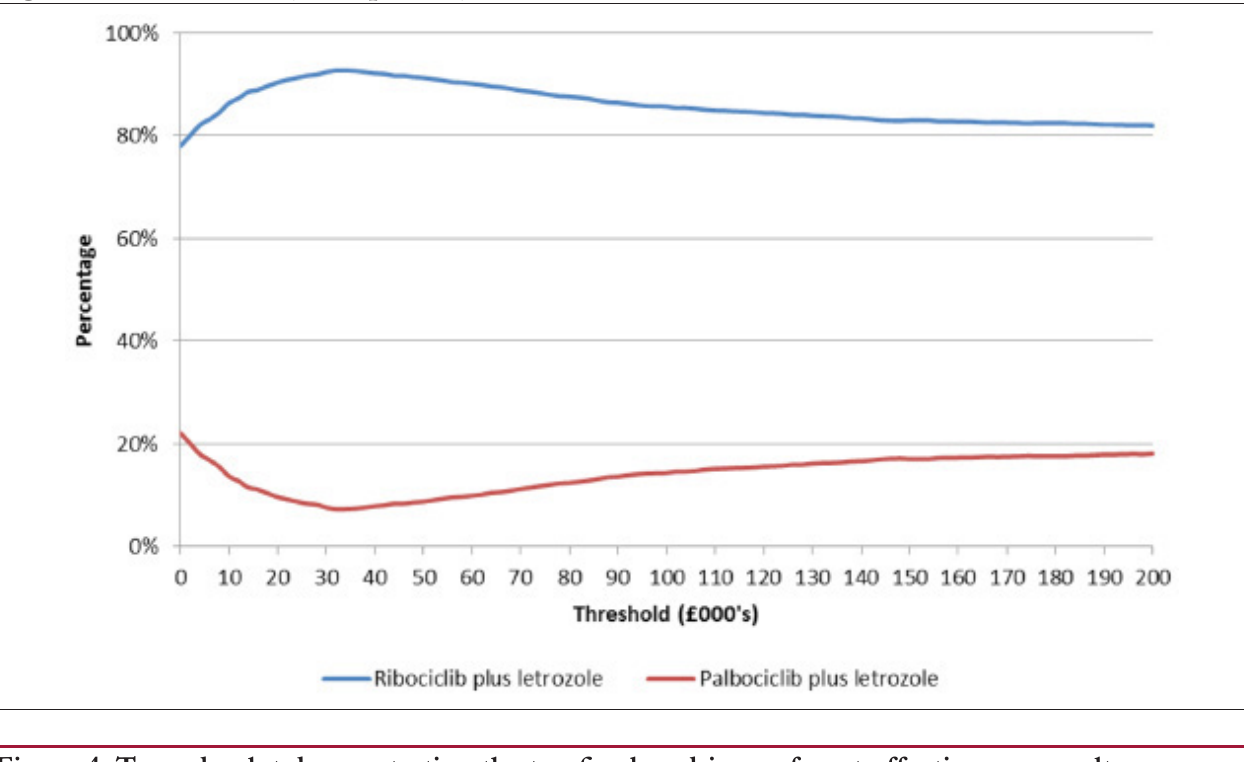
Figure 4. Tornado plot demonstrating the top five key drivers of cost-effectiveness results